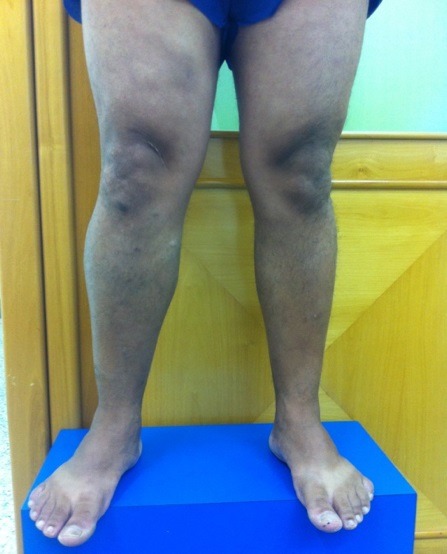
Lower limbs with patient standing upright, front view, showing asymmetry of right lower limb.